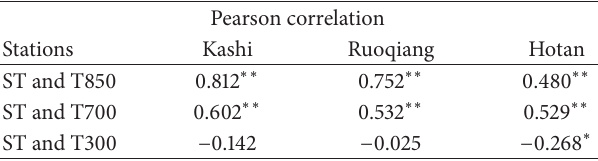
Table 3: Correlation analysis of ST and